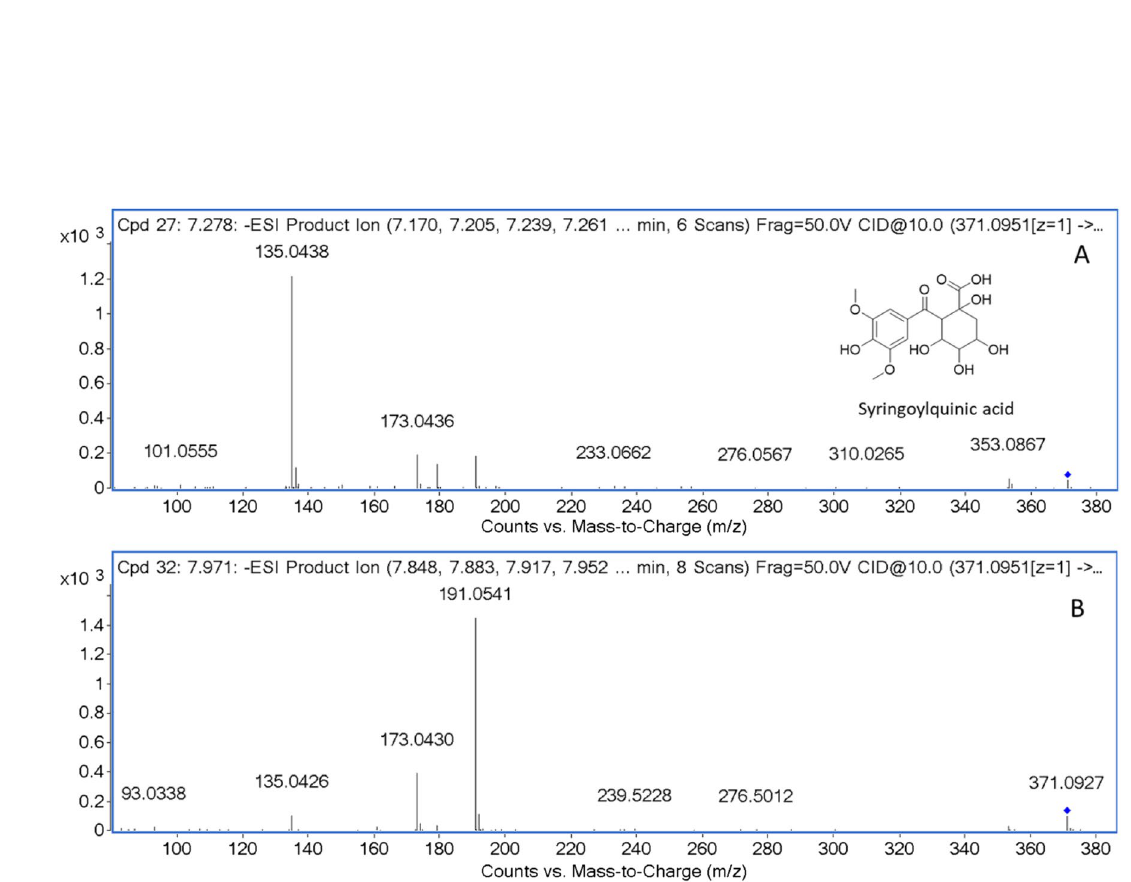
Table 2. Phytochemicals in F. dubia sap extract identified using LC–ESI–MS/QTOF method in the positive ionization mode.